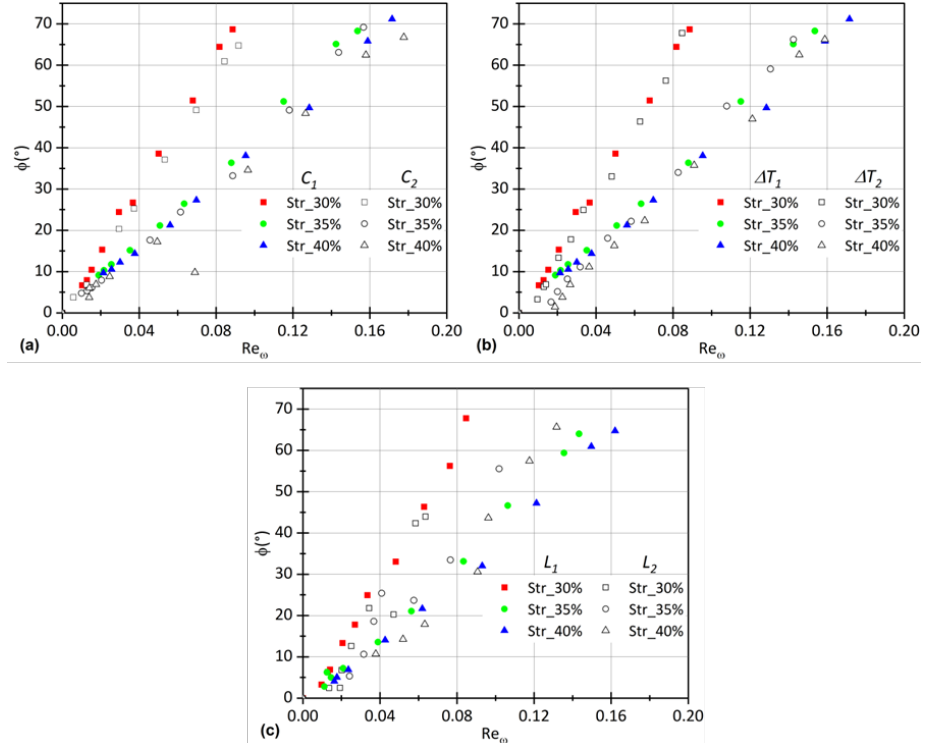
Figure 15. Evolution of the phase shift 𝜙 as a function of the kinetic Reynolds number Re ω for each regenerator. ( a ): Strokes ( C 1 = 64.4 mm and C 2 = 128.4 mm), ( b ): Temperature gradient ( Δ T 1 = 70 °C/10 °C and ∆ T 2 = 40 °C/10 °C), ( c ): Regenerator length ( L 1 = 60 mm and L 2 = 70 mm).